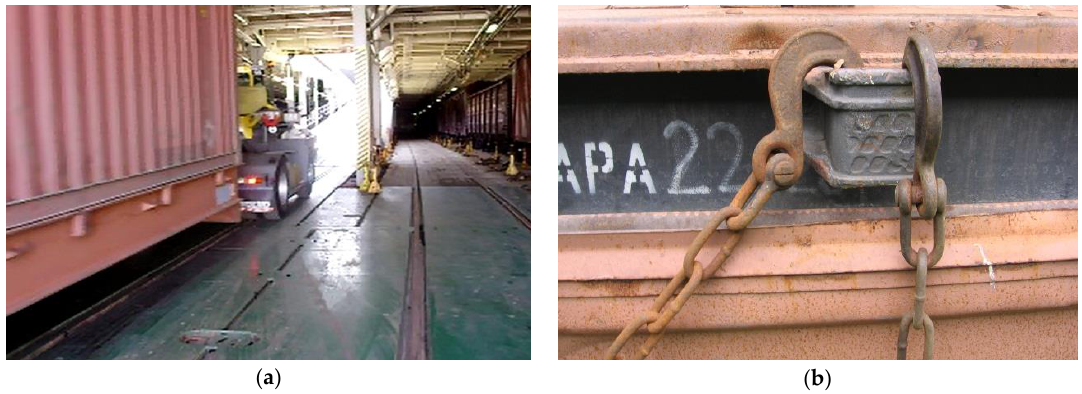
Figure 1. Combined transport trains ( a ) rolling of combined trains onto a rail ferry; ( b ) fastening a container train on the deck of a railway ferry.